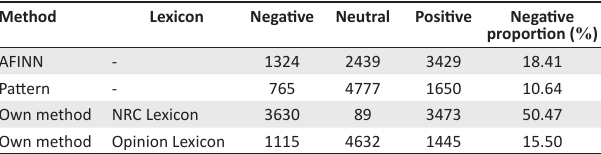
TABLE 5: Results of the sentiment analysis (with retweets, n = 7192) .